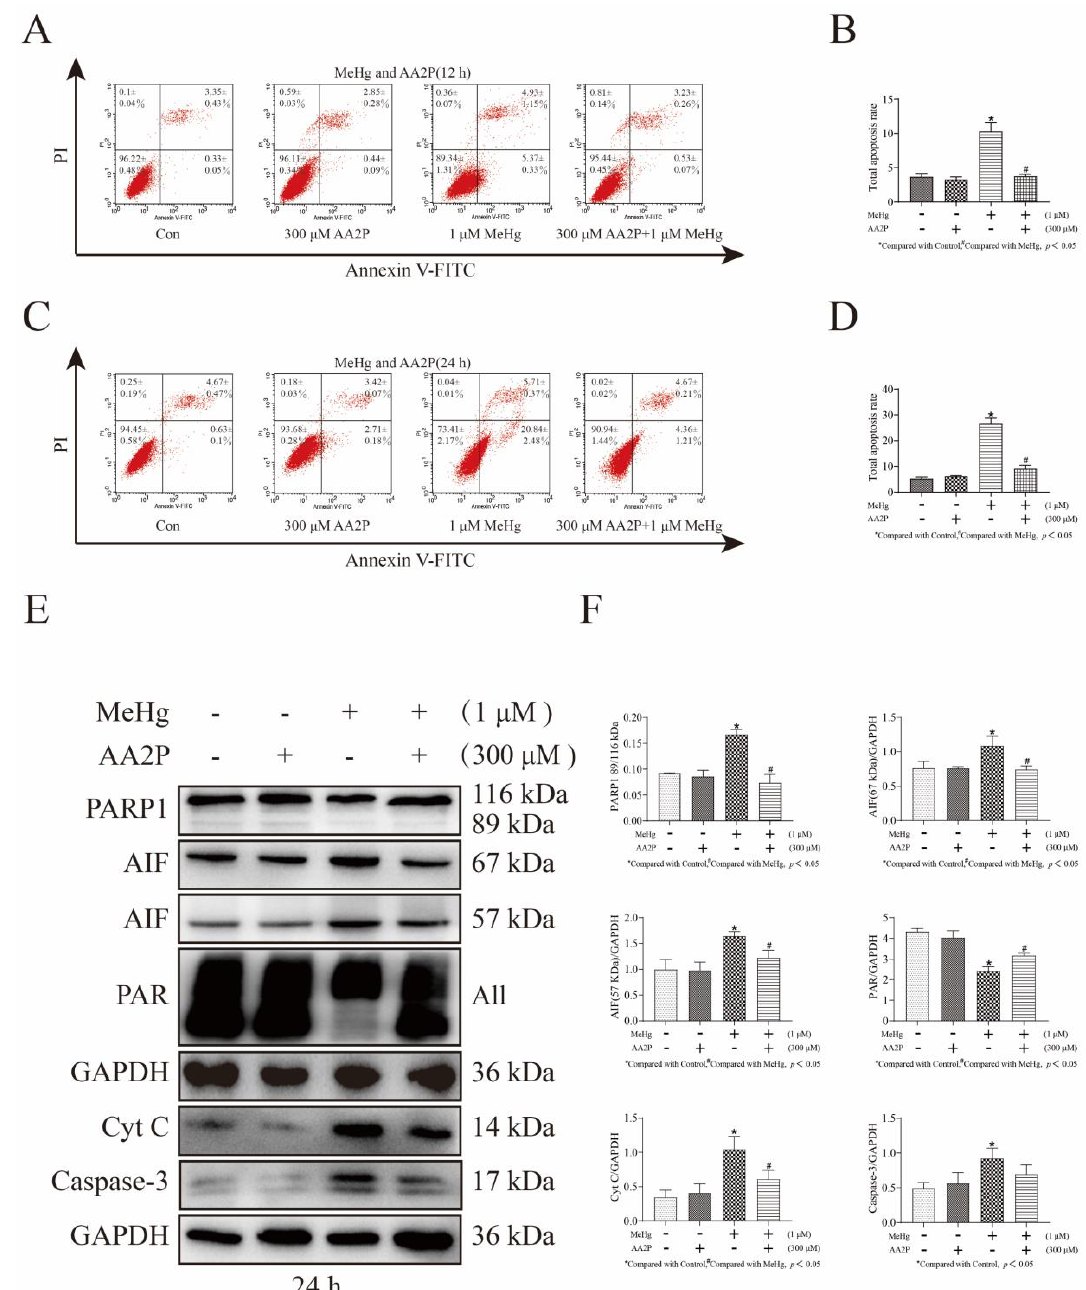
Figure 5. AA2P regulation of the PARP1/AIF and Caspase-3 pathways during MeHg-induced apoptosis of SH-SY5Y cells. ( A ) Flow cytometry detection of apoptosis in SH-SY5Y cells co-treated with 300 µ M AA2P and 1 µ M MeHg for 12 h. ( B ) GraphPad Prism 8 software analysis of the apoptosis rate of SH-SY5Y cells co-treated with 300 μM AA2P and 1 μM MeHg for 12 h. Statistical significance was determined using ANOVA, p < 0.05. ( C ) Flow cytometry detection of apoptosis in SH-SY5Y cells co-treated with 300 µ M AA2P and 1 µ M MeHg for 24 h. ( D ) GraphPad Prism 8.0.2 software analysis of the apoptosis rate of SH-SY5Y cells co-treated with 300 µ M AA2P and 1 µ M MeHg for 24 h. Statistical significance was determined using ANOVA, p < 0.05. ( E ) Western blot analysis of PARP1, PAR, AIF, Cyt C, and cleaved Caspase-3 in SH-SY5Y cells co- treated with 300 μM AA2P and 1 μM MeHg for 24 h. ( F ) The Tanon-2500 fully automated digital gel image analysis system was used to analyze the net optical density of the Western blot strips. All values are represented as means ± SD ( n = 3).